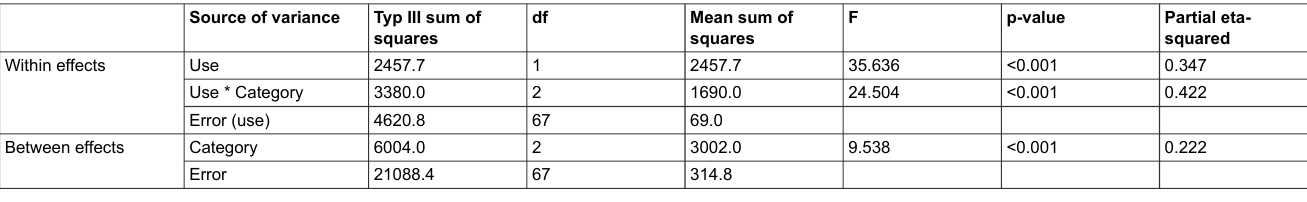
Table 2: Detailed results of the variance analysis with within effect question use (first versus second examination) and between effect question category (MKSAP-15/16, MKSAP-17 and Helvetic questions). Within effects are the main effect question use and the interaction question use * question category . Their variances (mean sum of squares) are both tested at the error variance for the within factor mean sum of squares of Error (Use), whereas the between group effect’s variance is tested at the error variance. Displayed are the re- sulting F-values together with their corresponding degrees of freedom, the significance of the effects and their partial eta-squared values as an estimate of the observed effect size. With a partial eta-squared of 0.422 the interaction is the largest observed effect which manifests itself in the fact that the difficulty between the first and second exam changes only for the MKSAP 15/16